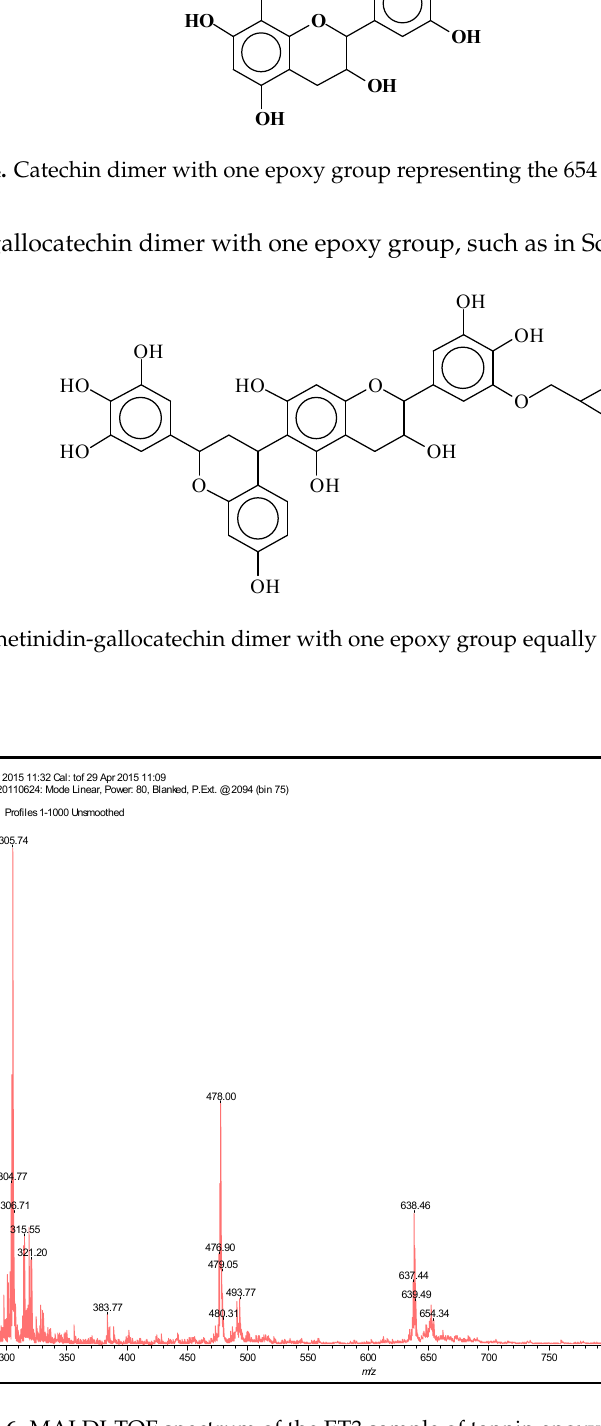
Figure 6. MALDI-TOF spectrum of the ET3 sample of tannin epoxy acrylate resin.